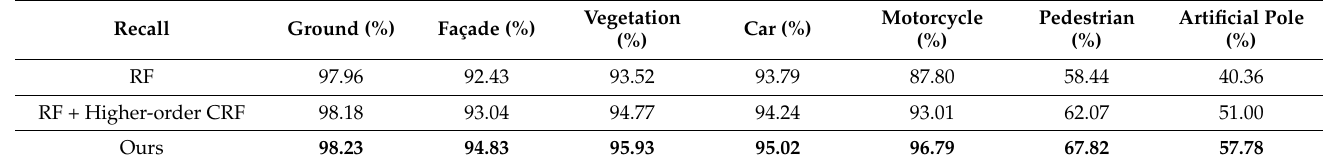
Table 10. Recall of the proposed method in different steps in the Wuhan University dataset.